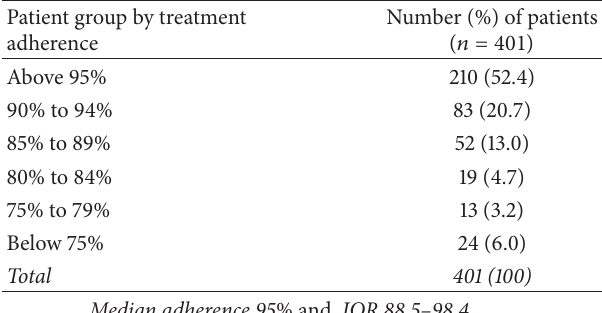
Table 2: Adherence to cART among the study